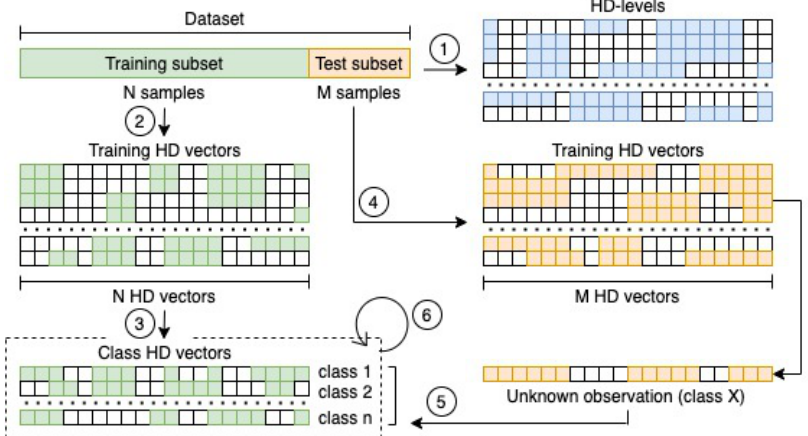
Figure 1. Flow chart of the whole procedure for building and testing the HD classification